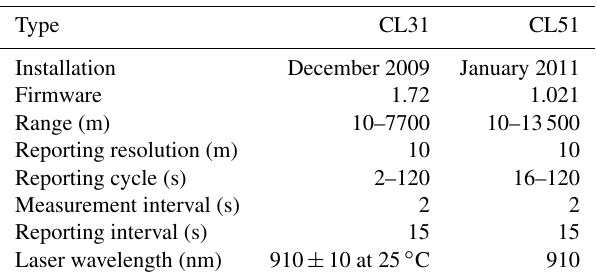
Table 2. Vaisala CL-31 ceilometer (PE) and CL-51 ceilometer (Neumayer III)